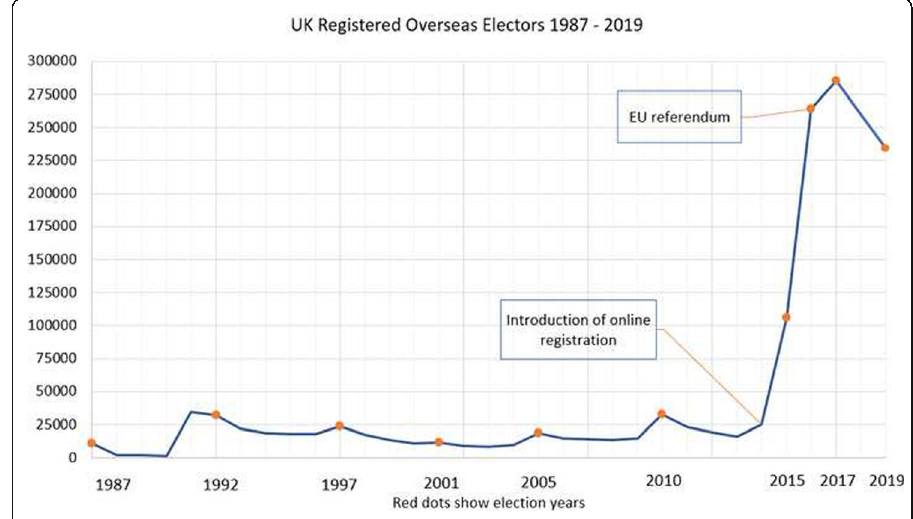
Fig. 1 UK registered overseas electors, 1987 – 2019. Source: Authors ’ creation from data published by Office of National Statistics